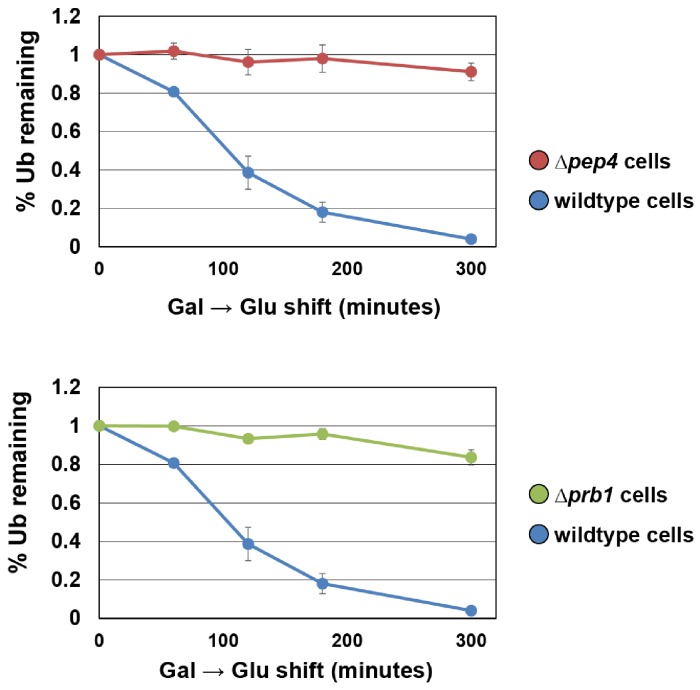
Quantitation of slot blot analysis of FLAG-ubiquitin levels following a galactose induction/glucose repression.Results plotted are the average values (n = 3) for each time point with error bars indicating standard deviation.